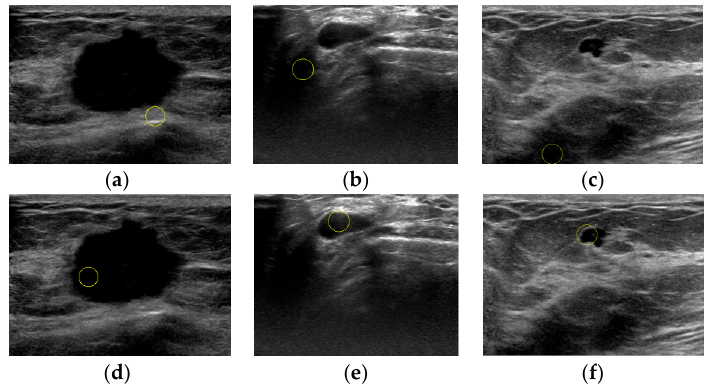
Figure 17. Localization results of three images in which Liu’s method failed while the proposed method succeeded. ( a ) Localization results of Liu’s method in an image with a large-sized tumor,